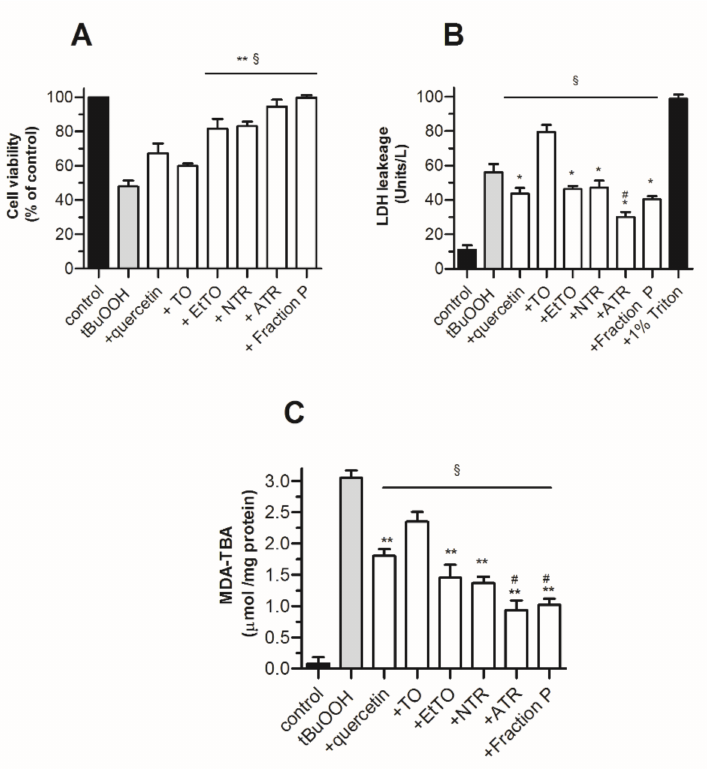
Figure 3. Protective effect of TO extracts and metabolites against t BuOOH-induced cytotoxicity in 3T3 fibroblasts (1 × 10 6 cells/mL). Cell viability and oxidative stress were assessed after 4 h of incubation in the absence or presence of test compounds at 15 µ g/mL, by ( A ) LDH leakage in culture supernatant, ( B ) neutral red-based viability assay, ( C ) MDA-TBA levels. Quercetin was used at 3 µ g/mL. Values represent means ± SEM ( n = 8). Statistics: * p < 0.05 and ** p < 0.01 vs. TO, # p < 0.05 vs. EtTO and § p < 0.01 vs. t BuOOH, by one-way ANOVA ( p < 0.01) followed by Newman–Keuls